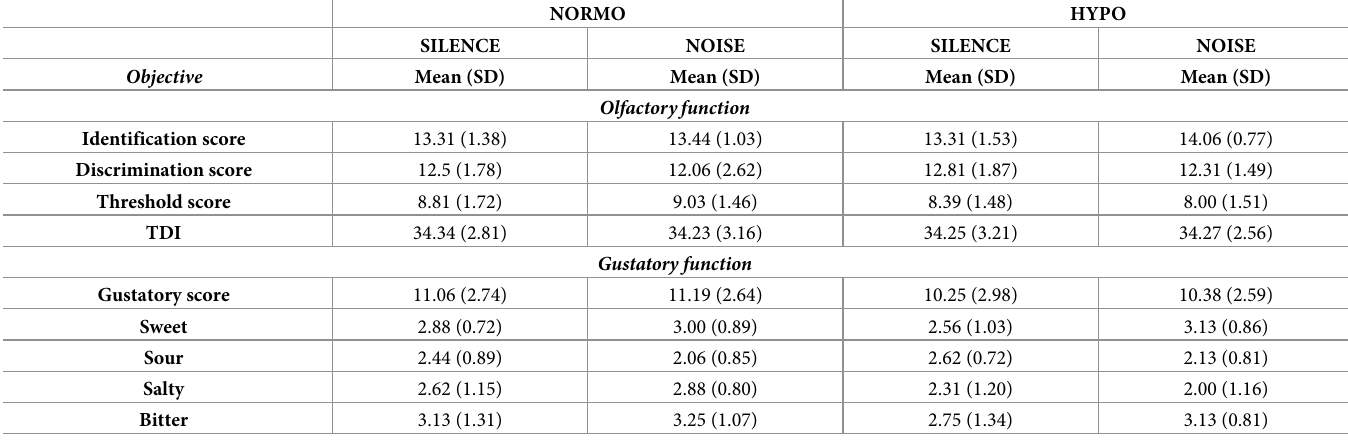
Table 1. Mean scores of olfactory and gustatory function for all